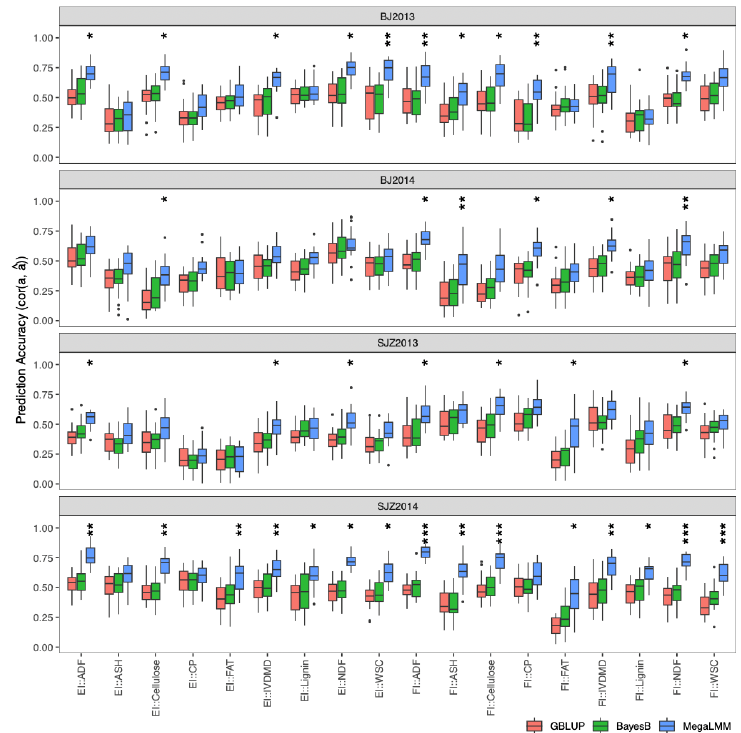
Figure 3. Distribution of prediction accuracies of the 18 stalk quality traits in the DH population across 20 resampling runs of cross-validation. The corrected resampled t-test was applied to test differences in prediction accuracy between the GBLUP, BayesB, and MegaLMM (multi-trait) models. Significance levels are indicated above each box, with *** significant at p < 0.001, ** significant at p < 0.01, and * significant at p <